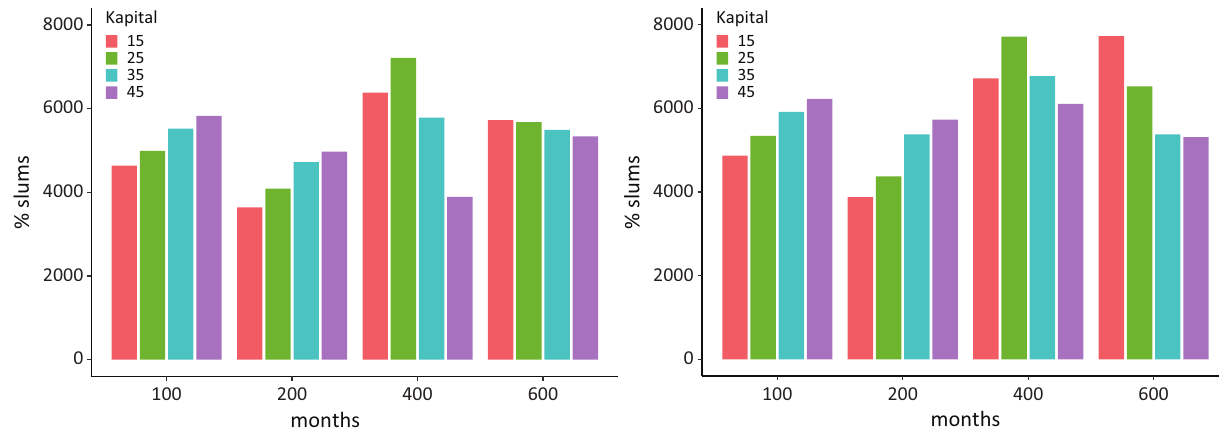
Figure 4. Mean property prices over time according to various levels of capital: no‐refugee scenario (left); ongoing refugee immigration scenario (right). Source: Termos et al. (2021, p.